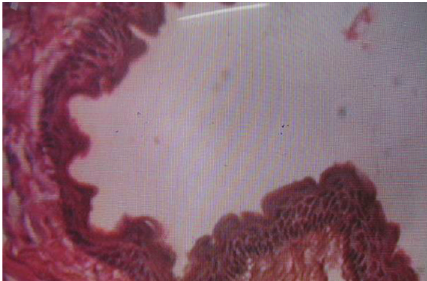
Figure 5: The epithelial lining has 6–8 cell thickness and palisaded basal cell